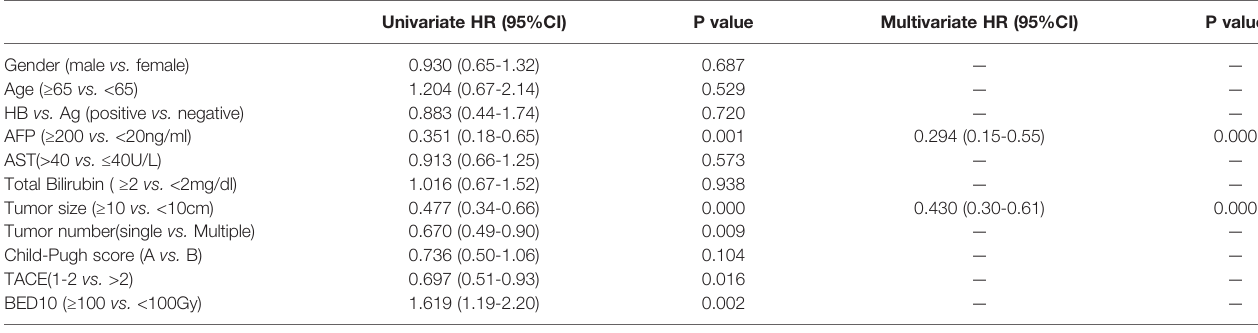
TABLE 3 | Univariate and multivariate analyses of prognostic factors for OS.